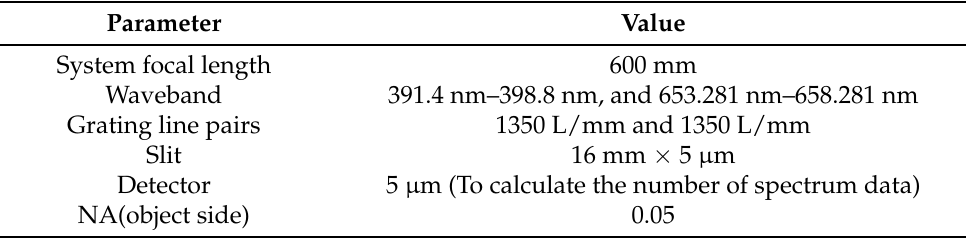
Figure 12. Optical structure of dual-gratings spectrometer. Table 2. Parameters of the experimental system.